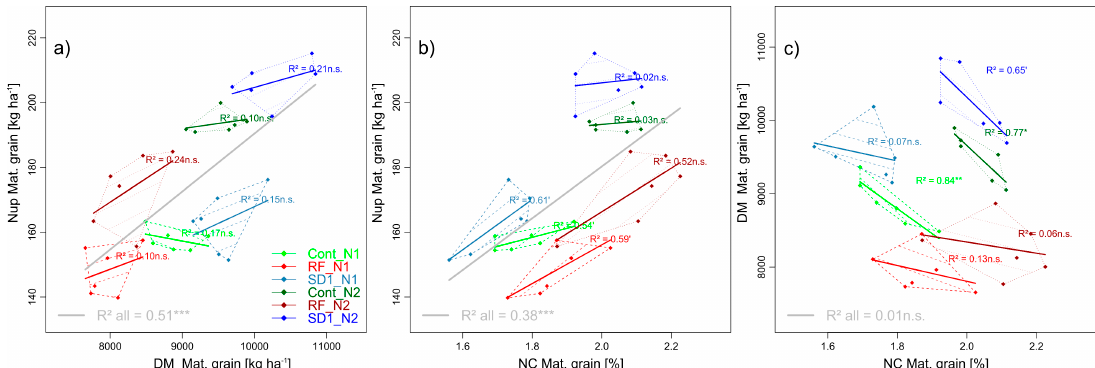
Figure 2. Pairwise trait relationships in trait complex a : The relationships between grain Nup and grain yield ( a ), grain Nup and grain N concentration ( b ) and grain yield and grain N concentration ( c ). Data points correspond to average cultivar values. N levels are distinguished by line types and color intensities (N1: Dashed lines and light colors, N2: Dotted lines and dark colors). Dashed and dotted lines delimit the bivariate data range covered by cultivars within MP × N-combinations. Colored regression lines indicate the linear trait relationships within MP × N-combinations and gray lines the regression line for the whole trial, calculated across the included data of reduced fungicide (RF), control (Cont) and sowing date 1 (SD1). Gray lines are only drawn for significant relationships ( p < 0.05). P -values of regression slopes are indicated as p < 0.01 (***), p < 0.01(**), p < 0.05 (*) and p < 0.1